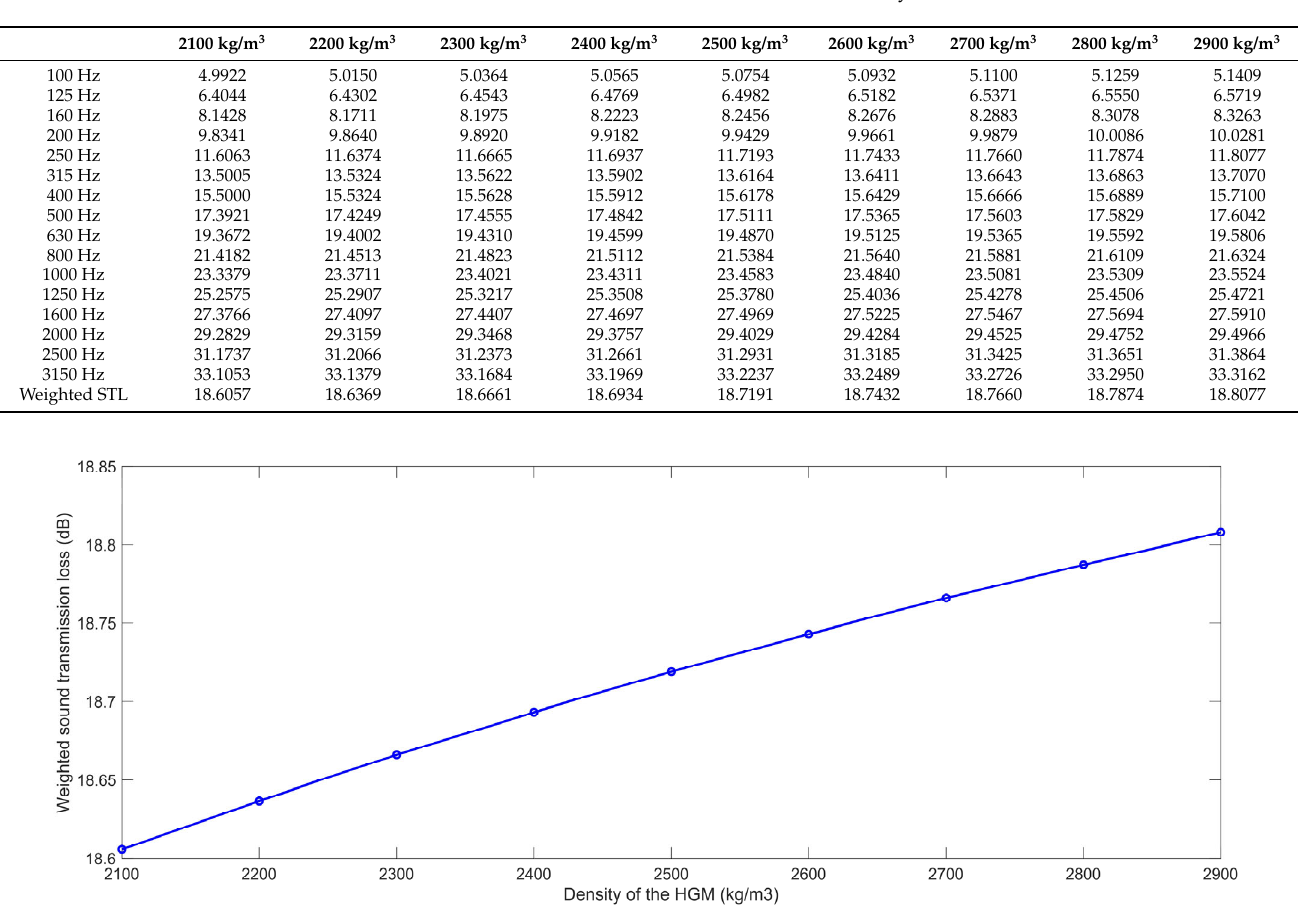
Table 8. The summarized STL data with the various density of the HGM.